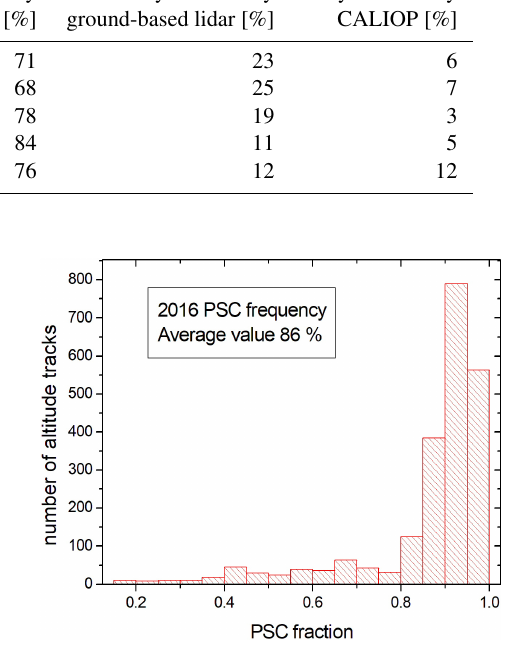
Figure 3. The frequency of PSC fractions is displayed for the 2016 CALIOP